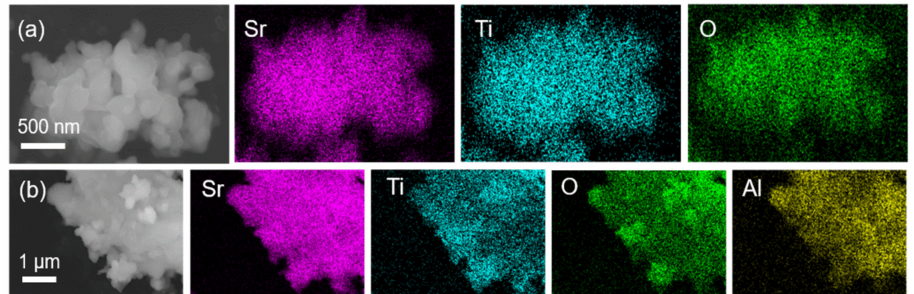
Figure 3. SEM-EDX images of ( a ) Sr 2 TiO 4 and ( b ) Sr 2 Ti 0.9 Al 0.1 O 4 . This is a figure. Schemes follow the same formatting.